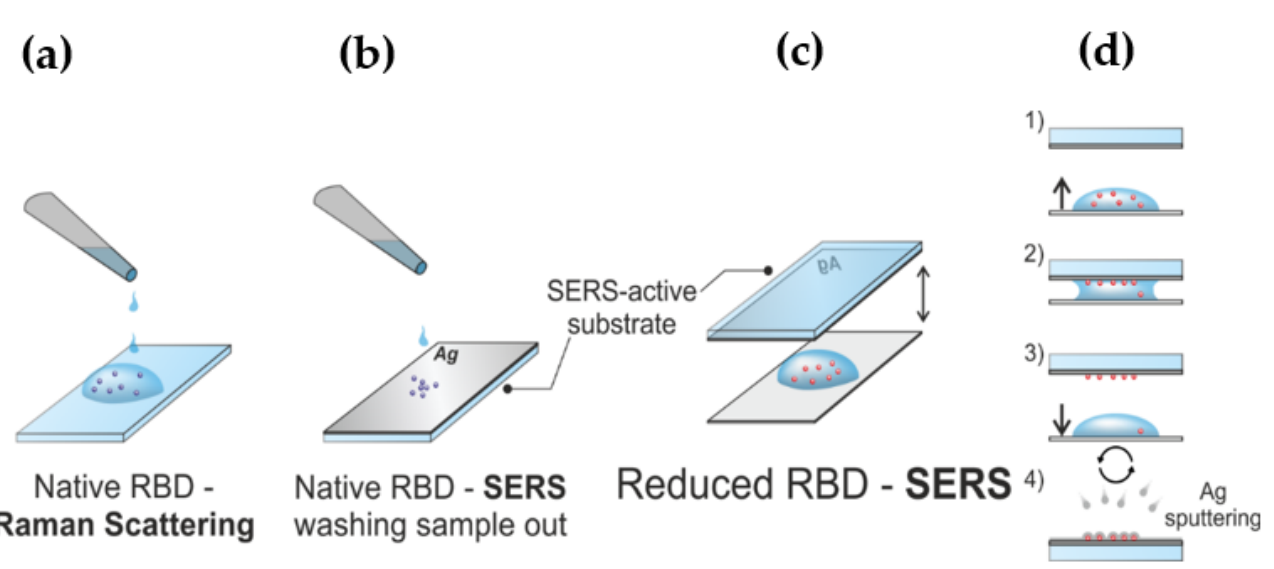
Scheme 1. A sketch of the procedure of sample deposition and treatment for recording Raman and SERS spectra. ( a ) For recording the conventional Raman spectrum of the native RBD, the protein solution was applied dropwise onto a glass slide and dried. The Raman spectra were recorded from a sample volume of ~10 9 nm 3 , which contained about 1.3 pg of protein. ( b ) For recording the SERS spectra of the native RBD, the protein solution was applied dropwise onto defect-free areas of the SERS-active metal film. After incubation, the substrates were washed with water. The SERS spectra were recorded from a sample volume of less than 2.2 × 10 6 nm 3 , which contained about 2.7 fg of protein. ( c ) For recording the SERS spectra of the reduced RBD, the SERS-active substrate was fixed, with the SERS-active silver side down. A drop of protein solution was applied onto the hydrophobic surface of the Parafilm film mounted on a slide. ( d ) Then, the slide was positioned in such a way that a defect-free region of the SERS-active silver substrate was strictly above the RBD drop ( d 1); the vertical (from bottom upwards) approach of the slide to the SERS-active substrate resulted in the drop spreading over the parafilm upon touching the SERS-active substrate ( d 2). After incubation, the SERS-active substrate was removed from the bench ( d 3) and washed intensely with a stream of water. The SERS spectra were recorded from a single protein aggregate shaped as a disk 300 nm in radius and 4 nm in height, which contained about 1 fg of protein. Application of an additional, optically transparent layer of silver onto the protein ( d 4) resulted in further order(s)-of-magnitude enhancement of the RBD SERS signal.